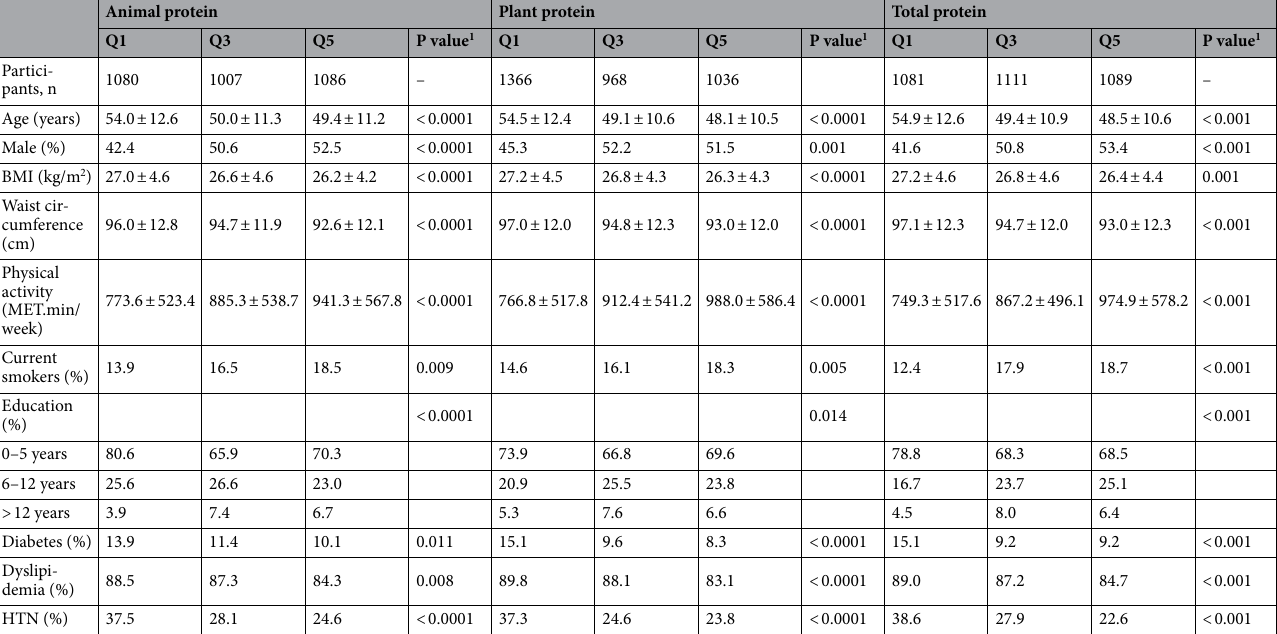
Table 1. General characteristics of participants at baseline according to quintiles of protein sources in the ICS. BMI body mass index, HTN hypertension, MET.min/week metabolic equivalent. h/day. 1 Derived from 1-factor ANOVA and chi-square test for continuous and categorical variables, respectively. 2 Values are mean ± SD (all such